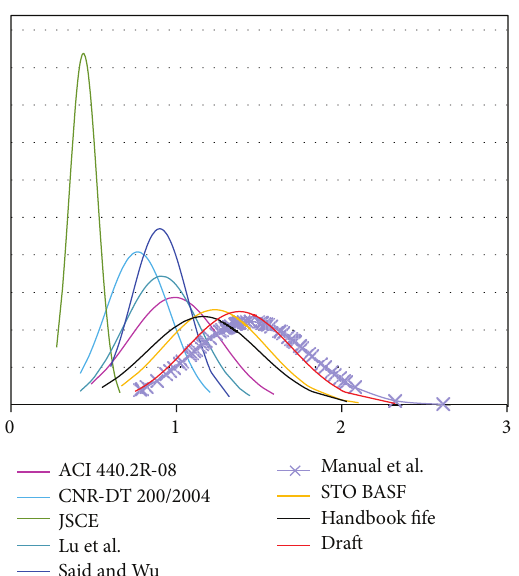
Figure 4: Normal distributions for proposed analytical formula 𝑥 1 .